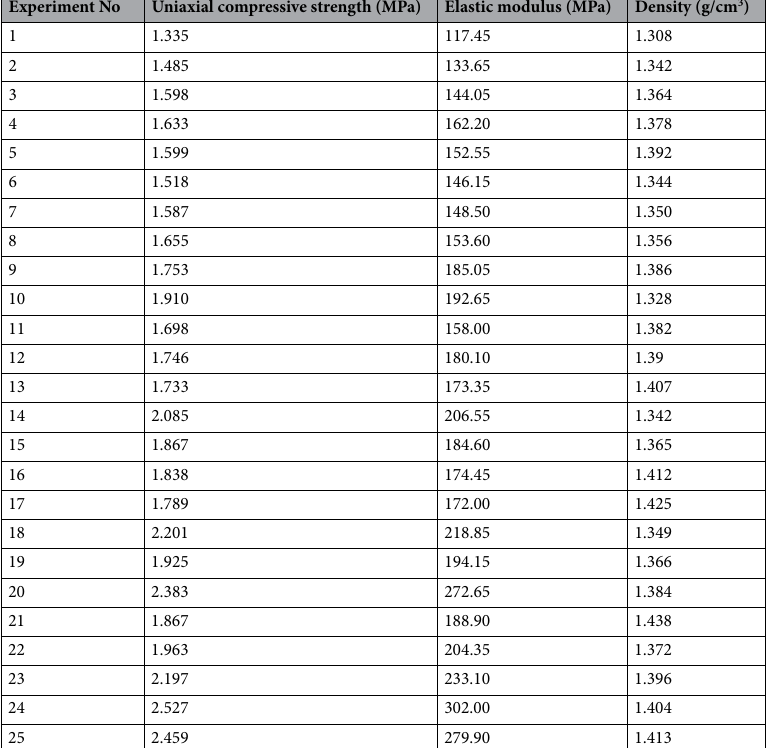
Table 5. Orthogonal test results of similar materials.